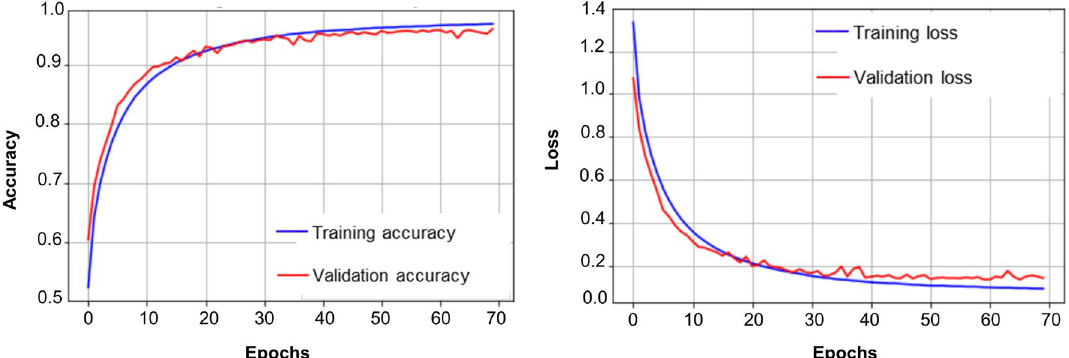
Fig. 8 Model performance on the training and validation set. The plot to the left shows the accuracy results by increasing the number of epochs, whereas the plot to the right shows loss results by increasing the number of